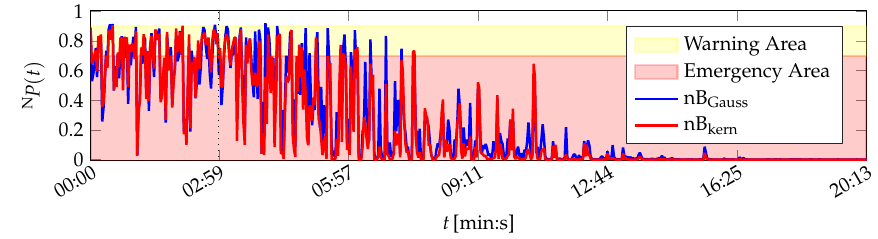
Figure 6. System health evaluation over time during static operation of the printing unit demonstrator (PU static ) by one-class naïve Bayes applying Gaussian (nB Gauss ) and kernel-density estimated (nB kern ) priors.